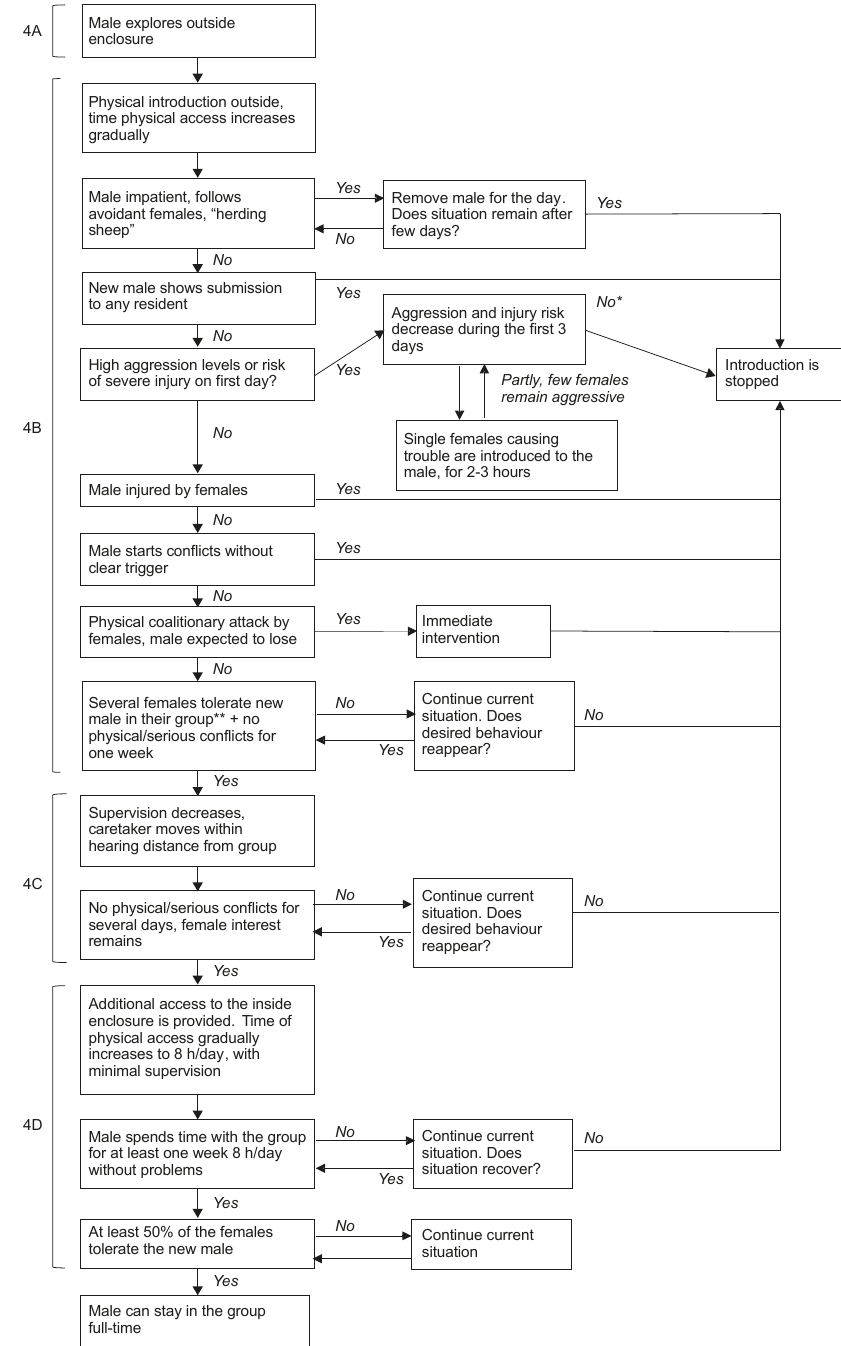
Figure 5. Step 4: The stepwise physical introduction of a new male into a breeding group, concerning the male exploring the outside enclosure (4A), the first days of physical interactions outside (4B), decreasing direct supervision (4C), and providing additional access to the inside enclosure (4D). * When the introduction cannot continue in the group because of one or a few highly aggressive females who have a history of extreme hostility towards new males, an alternative strategy could be to remove the aggressive female(s) and continue the introduction. ** for definition see [52].